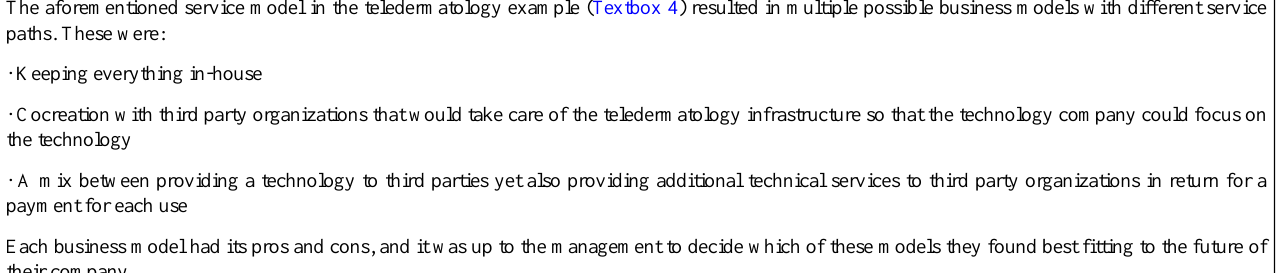
Textbox 6. Example Case: Multiple Business Model Opportunities for Different Scenarios